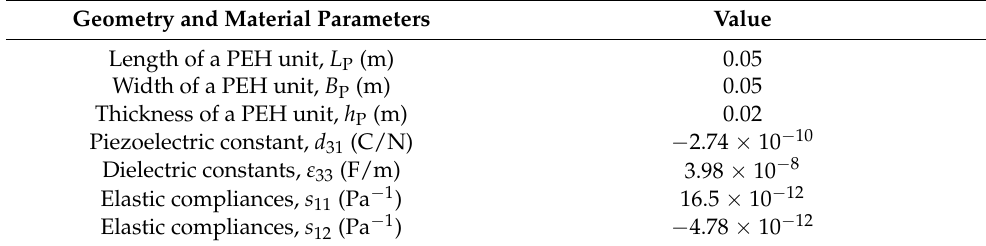
Table 1. Parameters of the PEH units. Geometry and Material